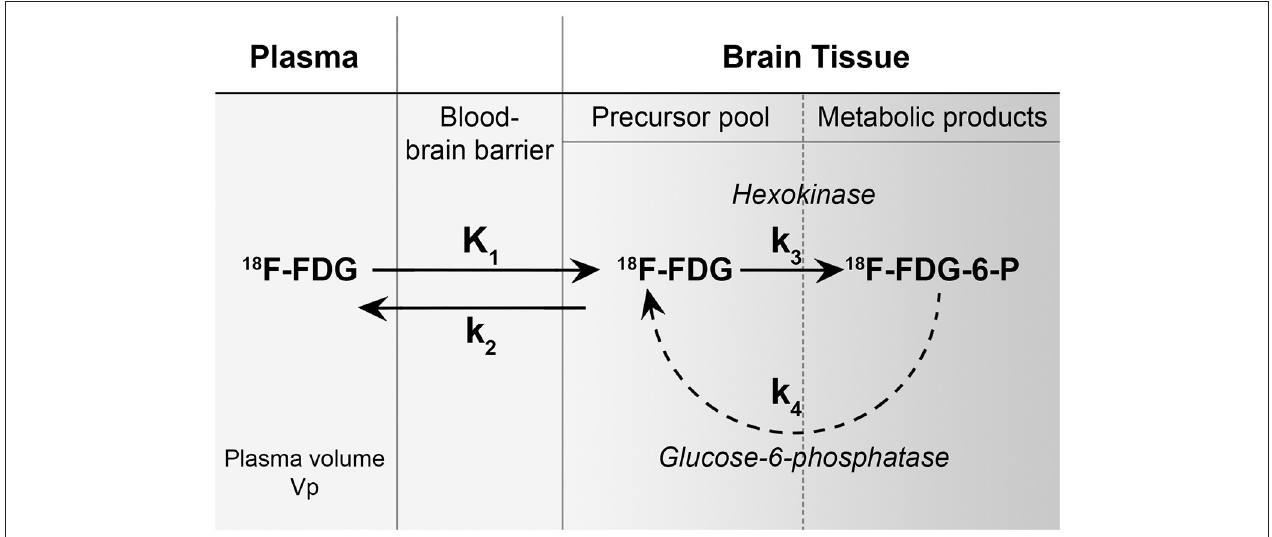
FIGURE 5 | A metabolism model of 18F-FDG showing three-compartments (plasma, precursor pool in brain tissue, and metabolic product pool in brain tissue) and the corresponding forward transfer coefficients (k 1 , k 2 , k 3 , and k 4 ). The forward transfer coefficient from the plasma volume into both normal brain tissue and glioblastoma (k 1 ) is significantly elevated compared to other tissue (for example, skeletal muscle). It is assumed that the phosphorylation of 18F-FDG (k 3 ) is a one-way process without dephosphorylation (k 4 ) and therefore, also assumed that the forward transfer coefficient from the precursor pool in brain tissue back into the plasma is negligible as phosphorylated glucose and FDG are unable to cross the blood-brain barrier. [Figure adapted from reference (9)].